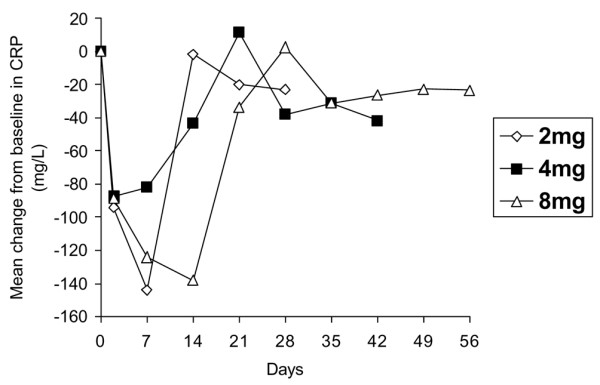
Mean changes from baseline (day 0, pre-infusion) in C-reactive protein (CRP; mg/L).